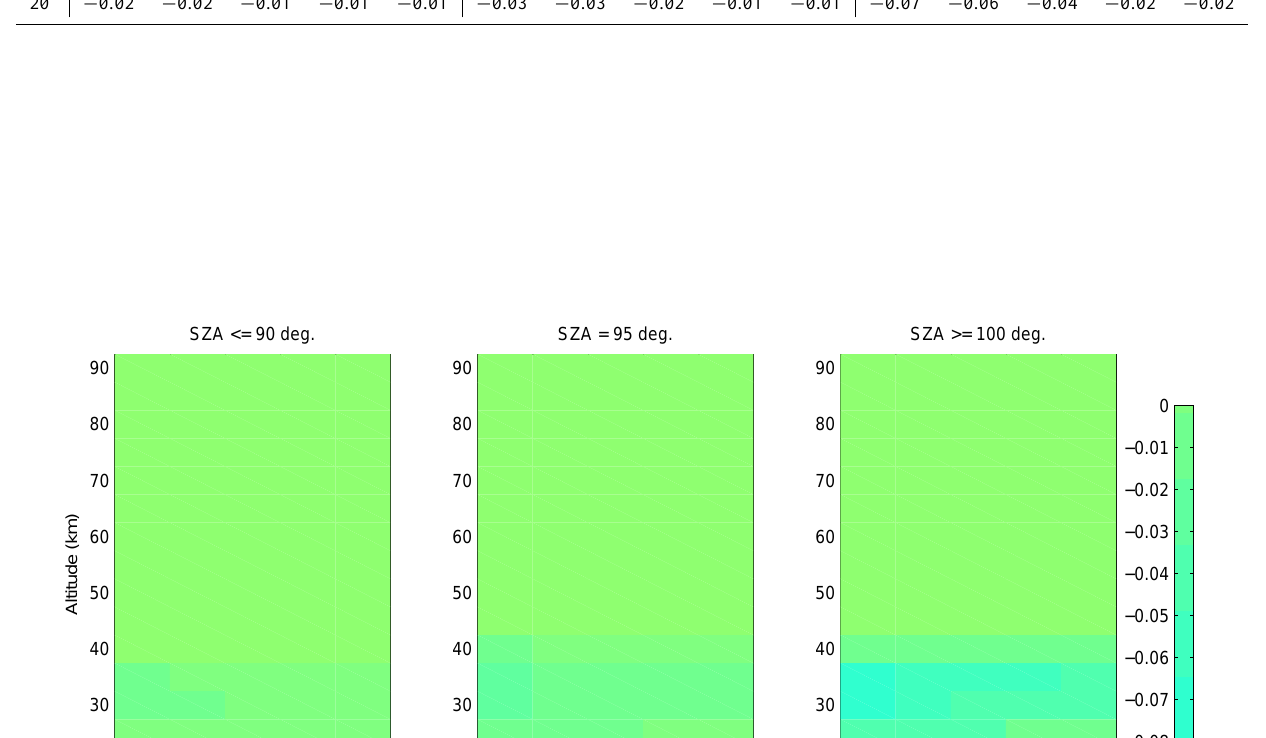
/Q for January 2 O 5